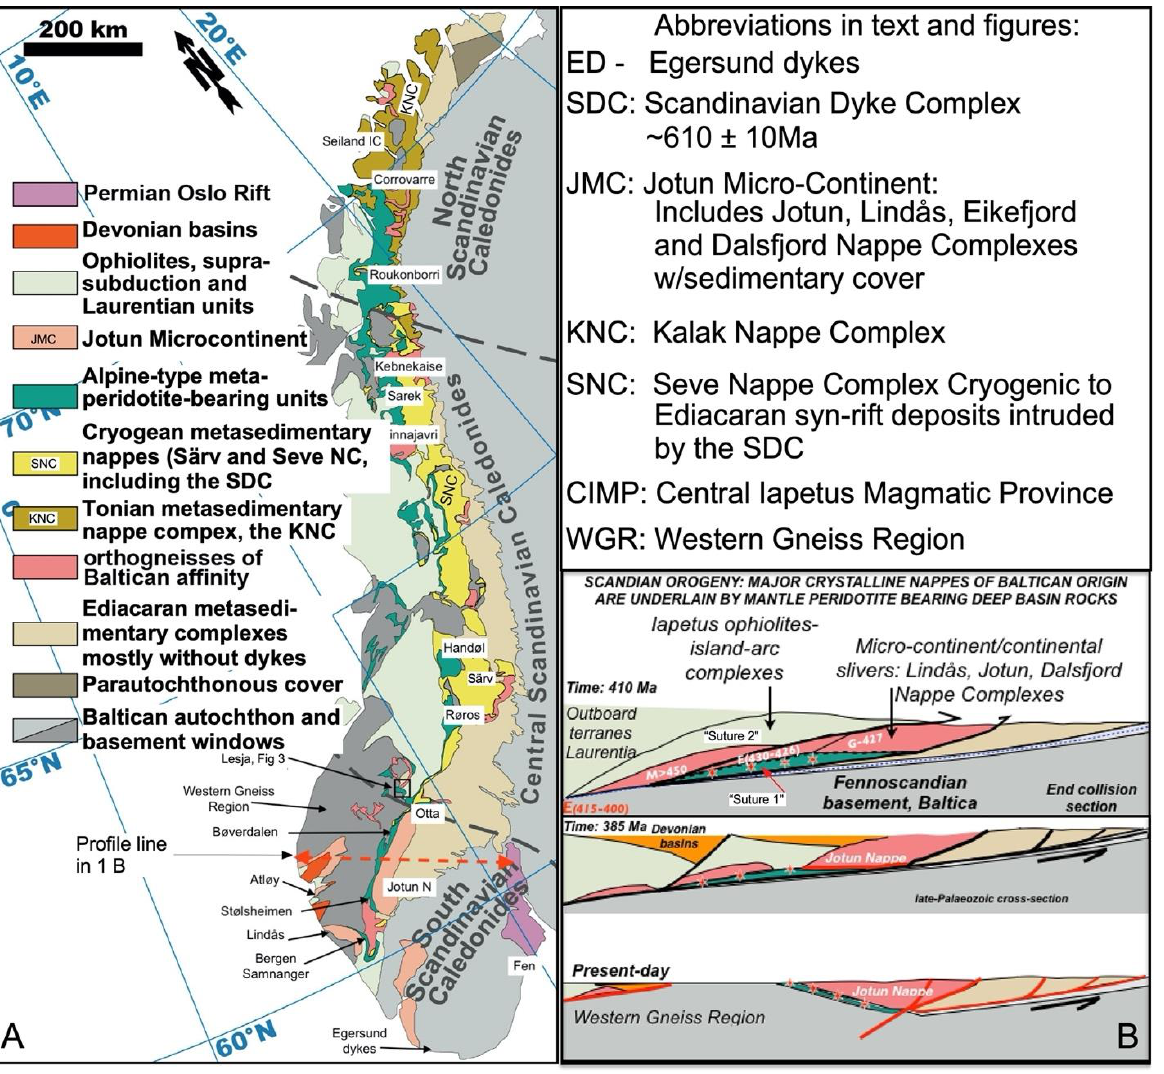
Figure 1. ( A ) The regional map and all abbreviations used in figures and text. ( B ) The evolutionary interpretation in a cross-section across of the Scandinavian Caledonides in South Norway (red-dotted line in ( A )). The cross-section interpretations in ( B ) illustrate the suggested evolution from present-day observations (base) to the end-collision stage of the Scandian Orogeny at ~410 (top) and at 385 Ma (middle). Notice the pronounced late- to post-orogenic modification of the collisional geometry after the Scandian collision. Red stars mark the presence of the metaperidotites exhumed prior to the Scandian Collision. Numbers in white (G-427, E-430-426, M > 450) show ages (in Ma) of granite (G) intrusions and high-pressure metamorphism (M, phengite cooling age), respectively. Suture 1 and Suture 2 in the top ( B ) panel refer to previous interpretation of the metaperidotite-bearing unit and the Iapetan oceanic units in Ref. [43]. The map legend in panel ( A ) is shown in tectono-stratigraphic order (base to top). Notice that allochthonous Baltican basement is found both below and above the metaperidotite-bearing unit in the South Scandinavian Caledonides. Dashed lines mark the boundaries between the South, Central and North Caledonides, also used in previous studies and works in progress.